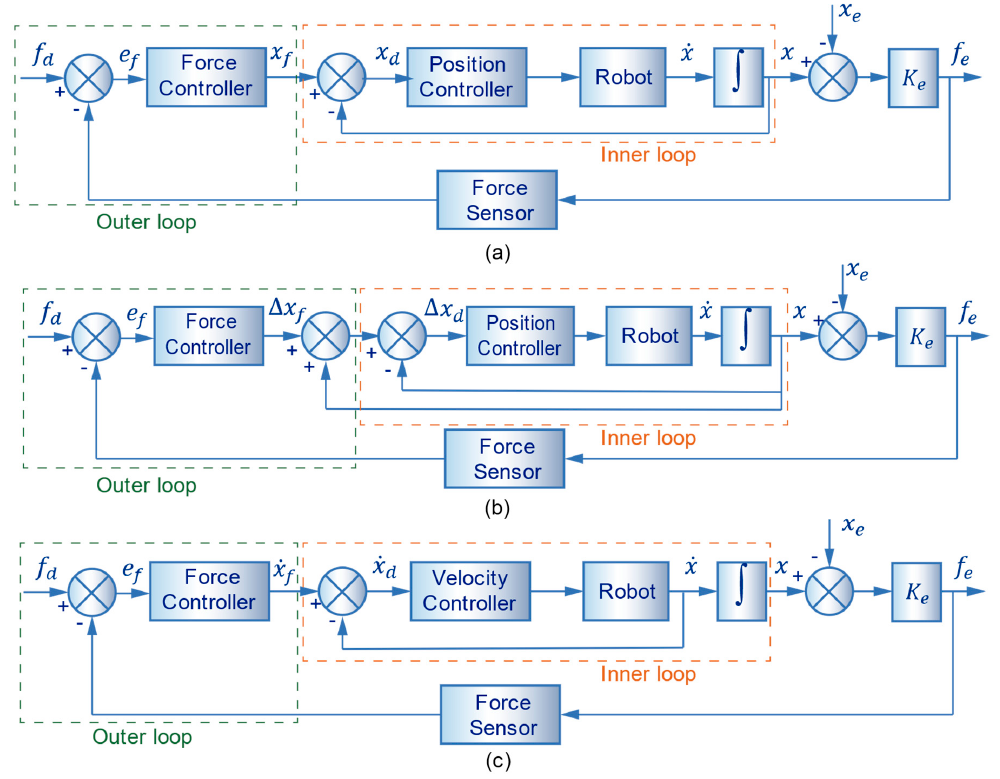
Figure 1. Force control with inner motion loops ( a ) with inner absolute position loop, ( b ) with inner incremental position loop, and ( c ) with inner velocity loop.